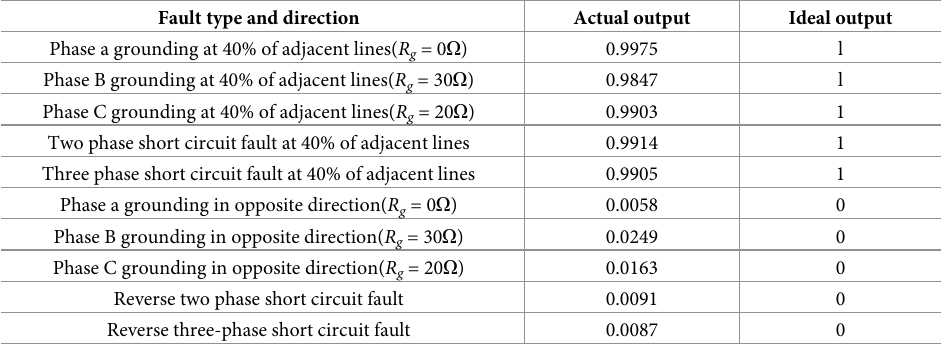
Table 2. ANN l test